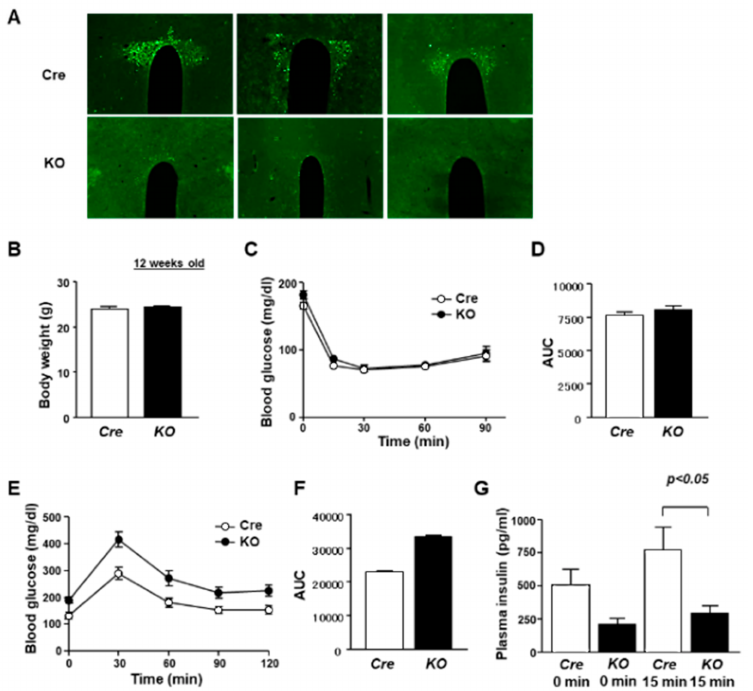
Figure 1. PVN-specific Bmal1 KO mice exhibited impairment of glucose intolerance. ( A ) Immunos- taining for BMAL1 in PVN coronal sections (rostral–caudal) of Cre and KO mice. Upper: Cre mice, lower: KO mice. Metabolic phenotypes of KO mice. ( B ) Body weight in Cre mice and KO mice at 12 weeks of age ( n = 6). ( C ) Blood glucose levels were measured in an ITT after intraperitoneal administration of insulin (1 IU per kg) to Cre mice (open symbol) and KO mice (filled symbol) at 12 weeks of age (each group, n = 6). ( D ) Area under the curve (AUC) of ITT (each group, n = 6). ( E ) Blood glucose during GTT after intraperitoneal administration of glucose (1 g per kg) to Cre mice (open symbol) and KO mice (filled symbol) at 12 weeks of age (each group, n = 6). ( F ) AUC of GTT (each group, n = 6). ( G ) Plasma insulin concentrations during GTT in Cre mice and KO mice ( n = 6). Data are presented as mean ± SEM. Cre vs. KO determined by one-way ANOVA followed by the Bonferroni test.